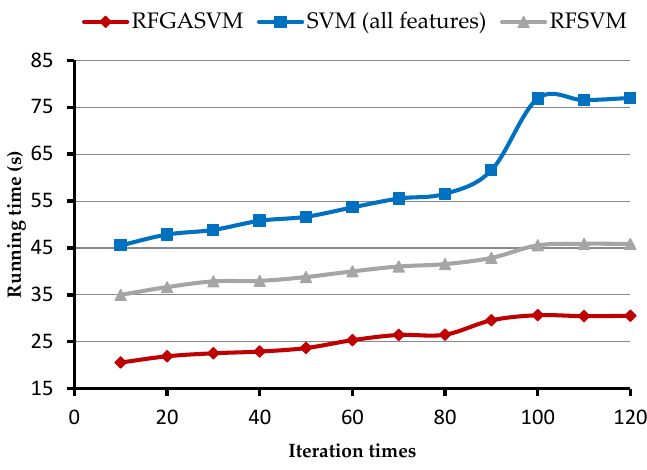
Figure 9. Comparison of the efficiency of proposed RFGASVM and related methods using different iteration times.